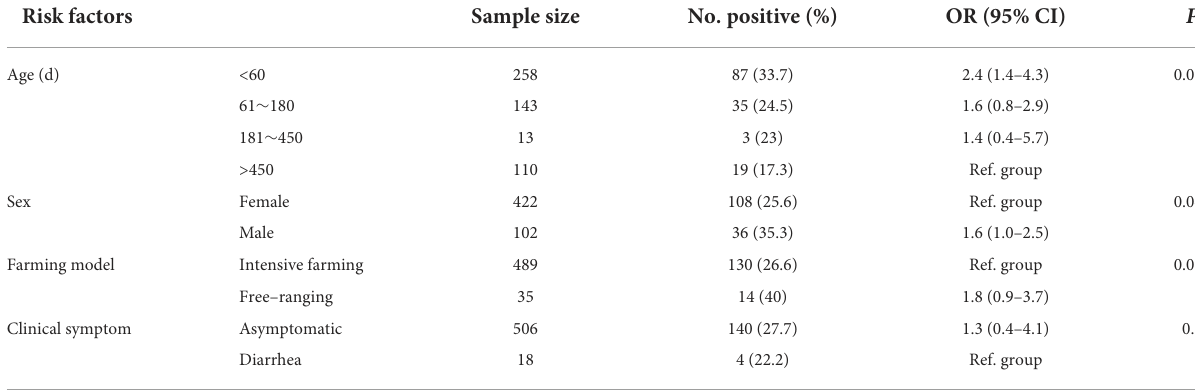
TABLE 3 Risk factors of Giardia duodenalis in Holstein